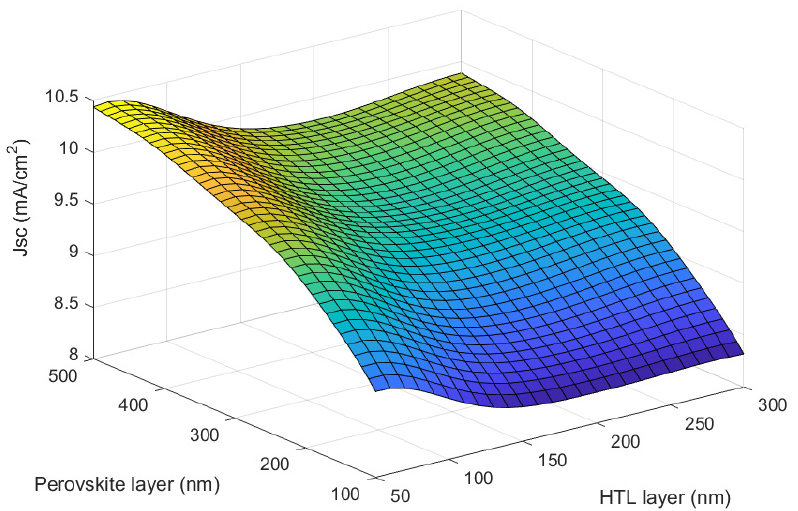
Figure 8. J SC of the fibre structure for varying perovskite and HTL layer thicknesses.